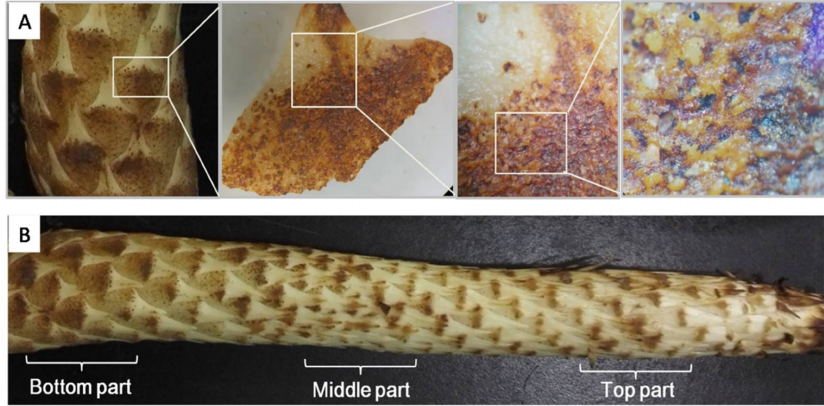
Figure 5. Stereomicroscopic vision of scale surface ( A ) and partition illustration ( B ) of C. deserticola.